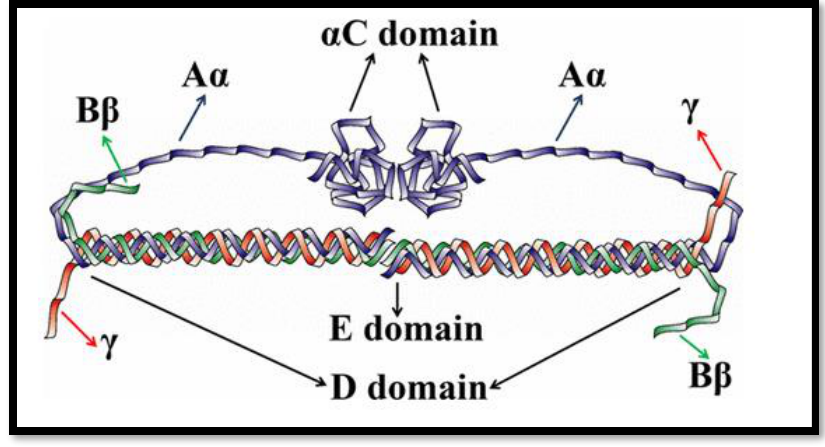
Figure 2. Fibrinogen structure [20].